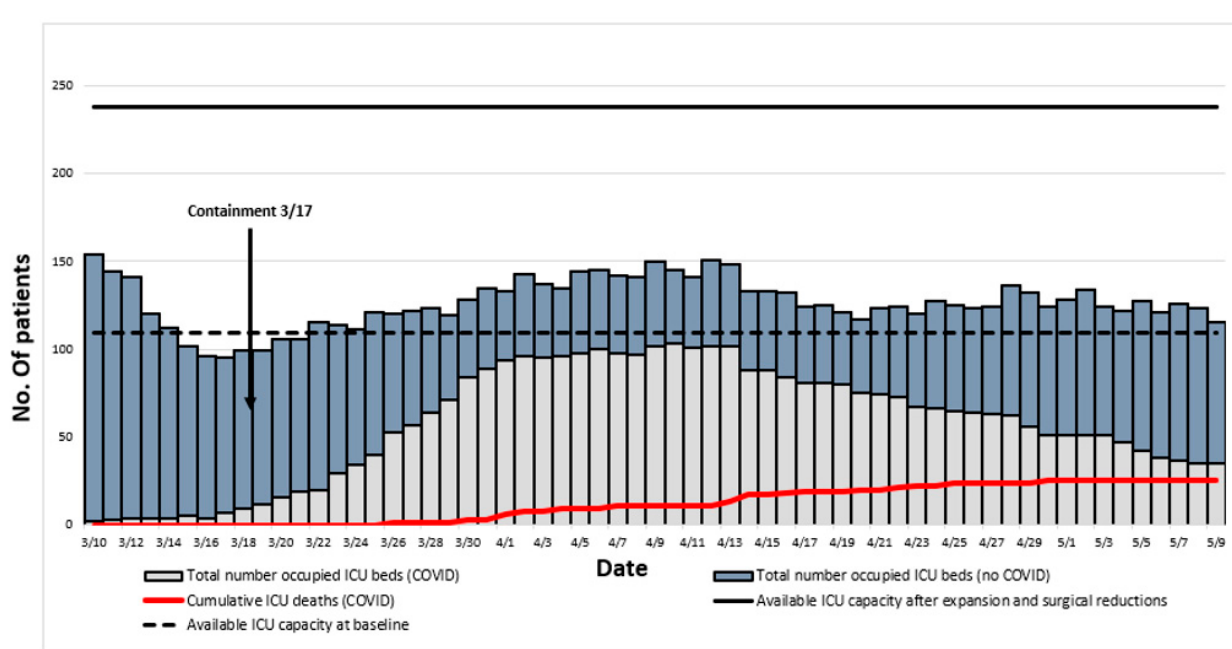
Figure 2. Evolution of daily inpatient prevalence and available ICU capacity.